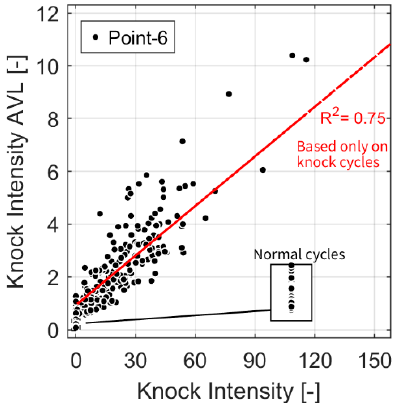
12 of 19 Figure 7. CA10 and CA50 of knock and normal cycles. Figure 8. Duration 10–50 and ignition delay of knock and normal cycles. 3.2. The Conventional Knock Determinations Figure 9 reveals that IKI and KI_AVL were in good agreement, with the exception of